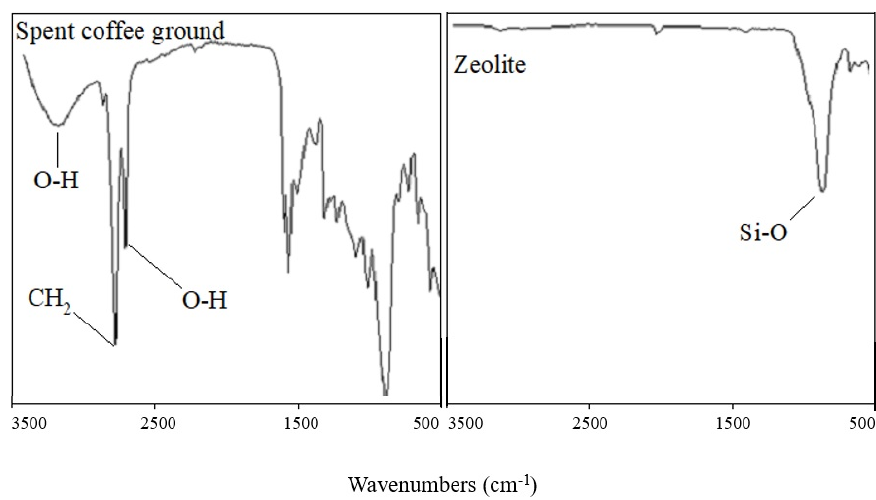
Figure 1. Fourier transform infrared spectroscopy (FT-IR) spectrum of spent coffee grounds and zeolite measure by attenuated total reflectance method.